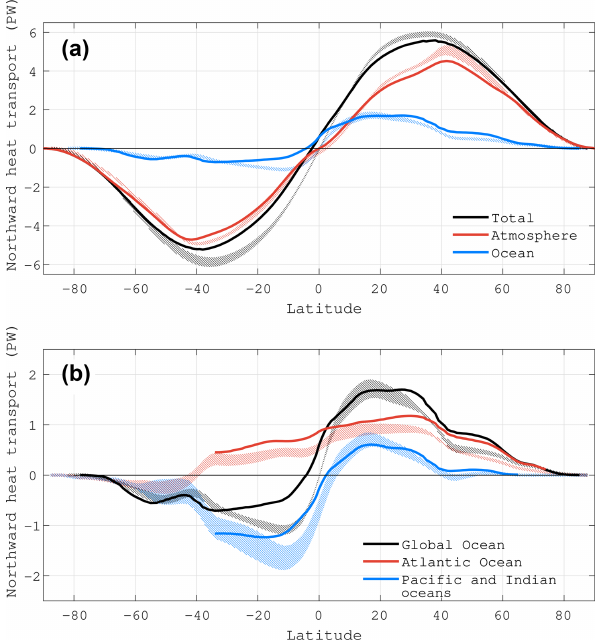
Figure 6. Simulated historical (1976–2005 mean) northward heat transport for (a) global atmosphere, ocean, and total, and (b) global ocean, its decomposed Atlantic Ocean and Pacific and Indian oceans. The corresponding hatched areas with uncertainties are es- timates from Fasullo and Trenberth (2008). In the model estimation, the ocean heat transport is calculated directly from the ocean model, and the atmospheric heat transport is derived by meridional integra- tion of the difference between the zonal integration of the net TOA and surface heat